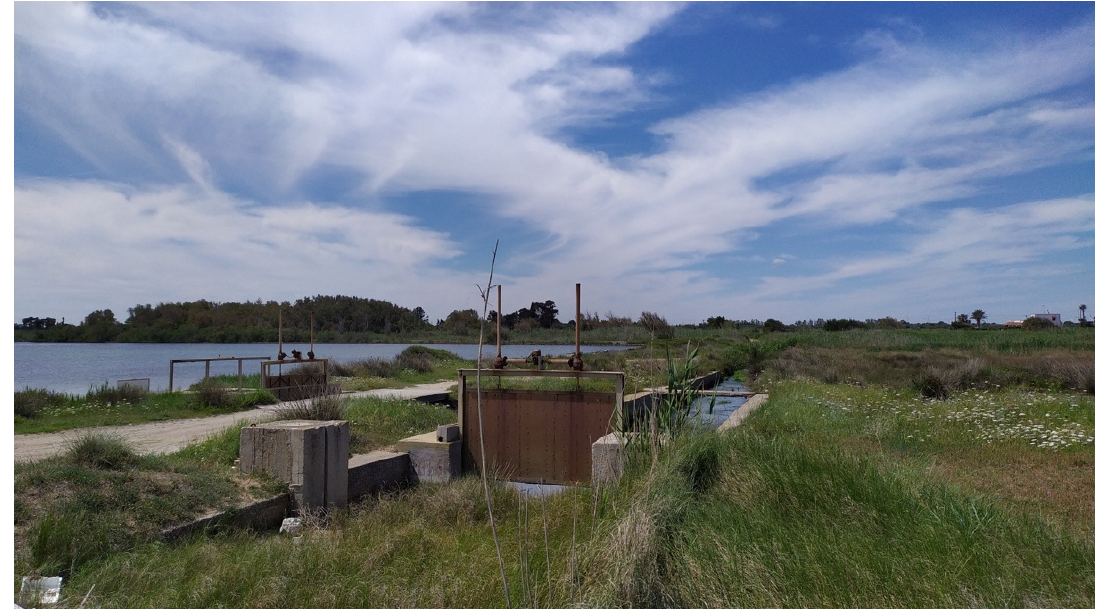
Figure 4. The water of Giammatteo Channel is canalized into the sea or in the Acquatina di Frigole lagoon through closed system of dams.